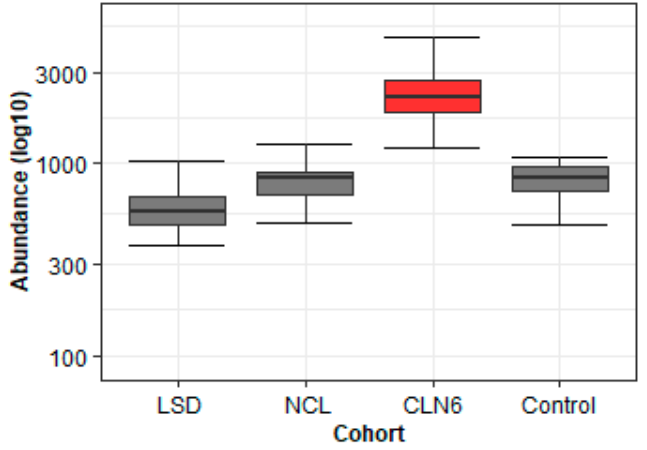
Figure 9. Boxplots showing the “behavior”:abundance distribution of a CLN6 (red color) specific biomarker candidate (4.42_384.3240n) in four cohorts (LSD n = 27, NCL n = 19, CLN6 n = 30, control n = 20) using methanol extraction. The circles represent the outliers. Boxes represent the 25th and 75th percentiles, while bars represent minimum and maximum